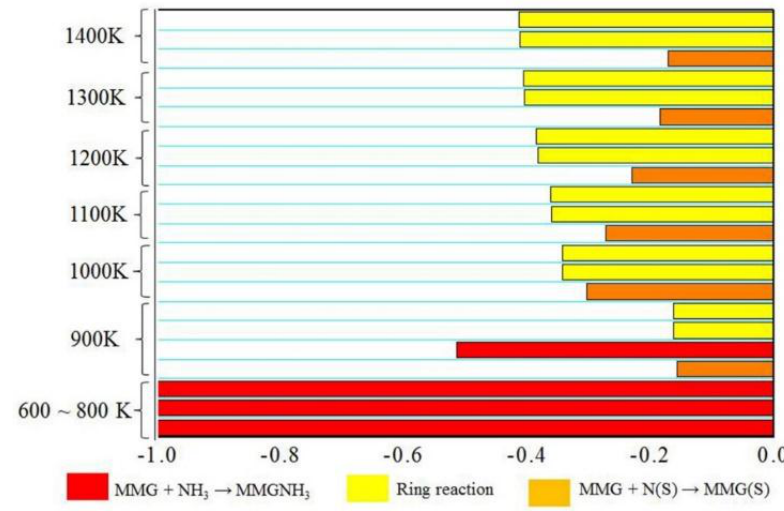
Figure 7. ROP analysis for DMGa in the gas phase.